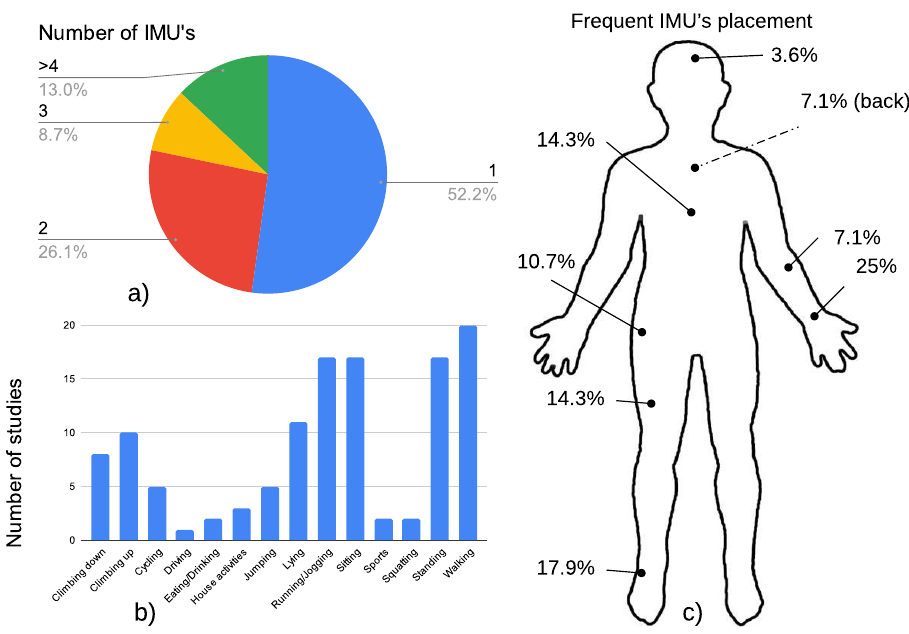
Figure 1. Representation of ( a ) the number of IMUs included in the literature review, ( b ) the most common human activities detected, and ( c ) the usual sensor